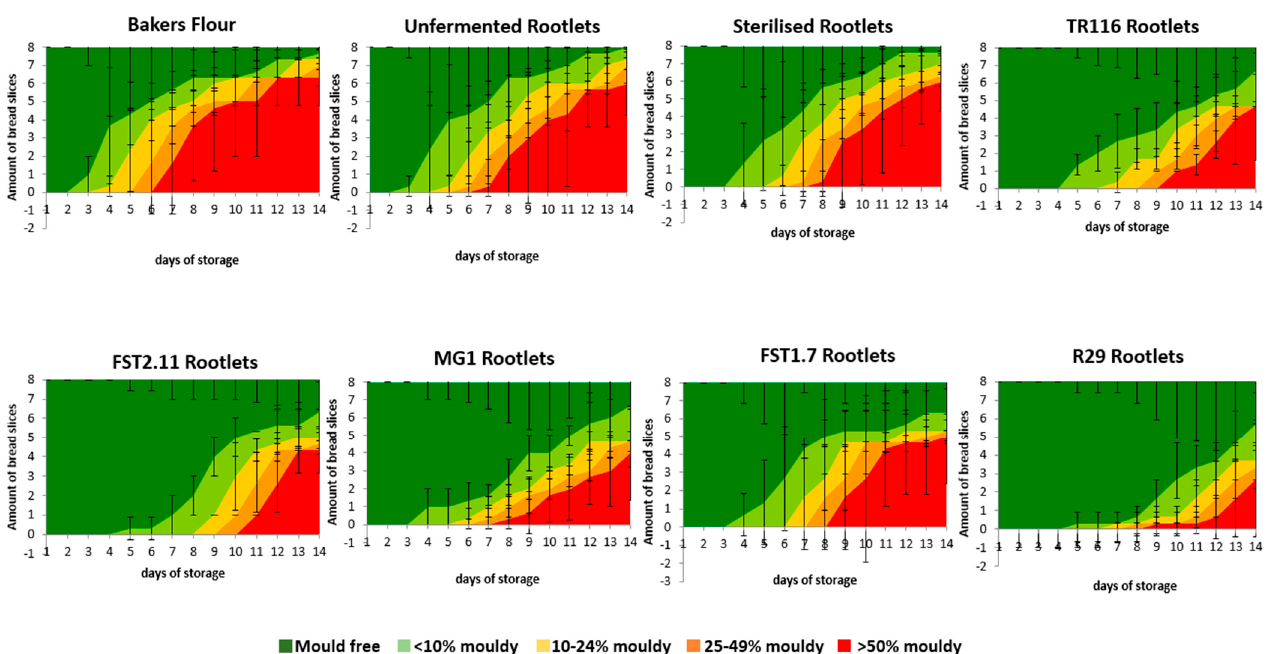
Figure 3. Fungal shelf-life evaluation of bread containing unfermented and fermented BR. TR116, FST2.11, MG1, FST1.7, and R29 denote BR recipes fermented with the strains Leuconostoc citreum TR116, Lactobacillus amylovorus FST2.11, Weissella cibaria MG1, Lactiplantibacillus plantarum FST1.7, and Limosilactobacillus reuteri R29. The graph represents the means of three independent batches, with error bars representing the standard deviation between batches.